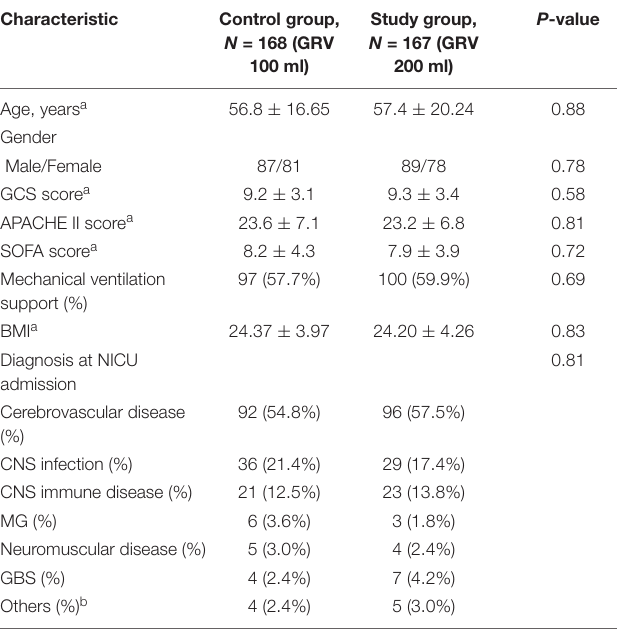
TABLE 1 | Characteristics of patients in two